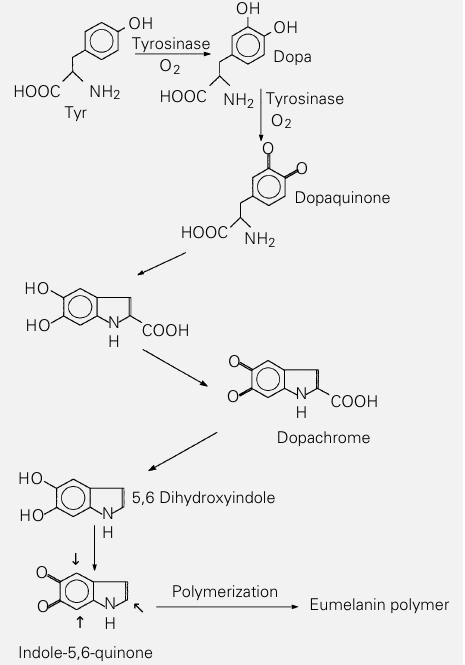
Figure 2 - Photooxidation of ty- rosine. Melanin polymerization (small arrows, sites of polymer-